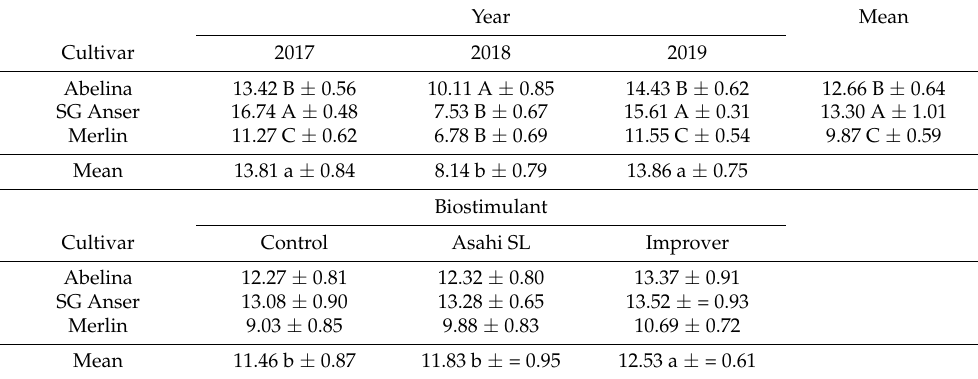
Means in rows followed by different letters in lowercase: a and b (for years and biostimulants) differ significantly at p ≤ 0.05. Means in columns followed by different letters in uppercase: A, B, and C (for cultivars and the interaction: years × cultivars) differ significantly at p ≤ 0.05; ± Se (standard error) value. Table 9. Number of plants per 1 m 2 according to years and cultivars (plants/m 2 ).